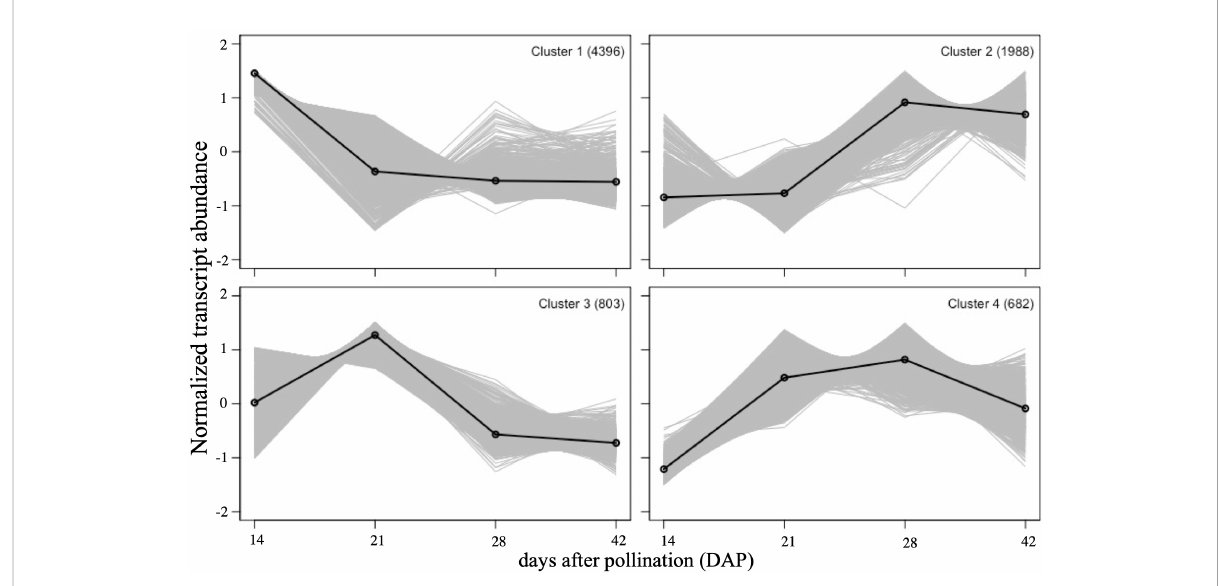
FIGURE 3 Self-organizing map (SOM) clustering. SOM clusters of DE genes showing their expression patterns during four stages of seed development. The number of DE genes in each cluster is indicated in top right. Solid lines represent the group mean of gene expressions in cluster. Each stage is represented by three biological